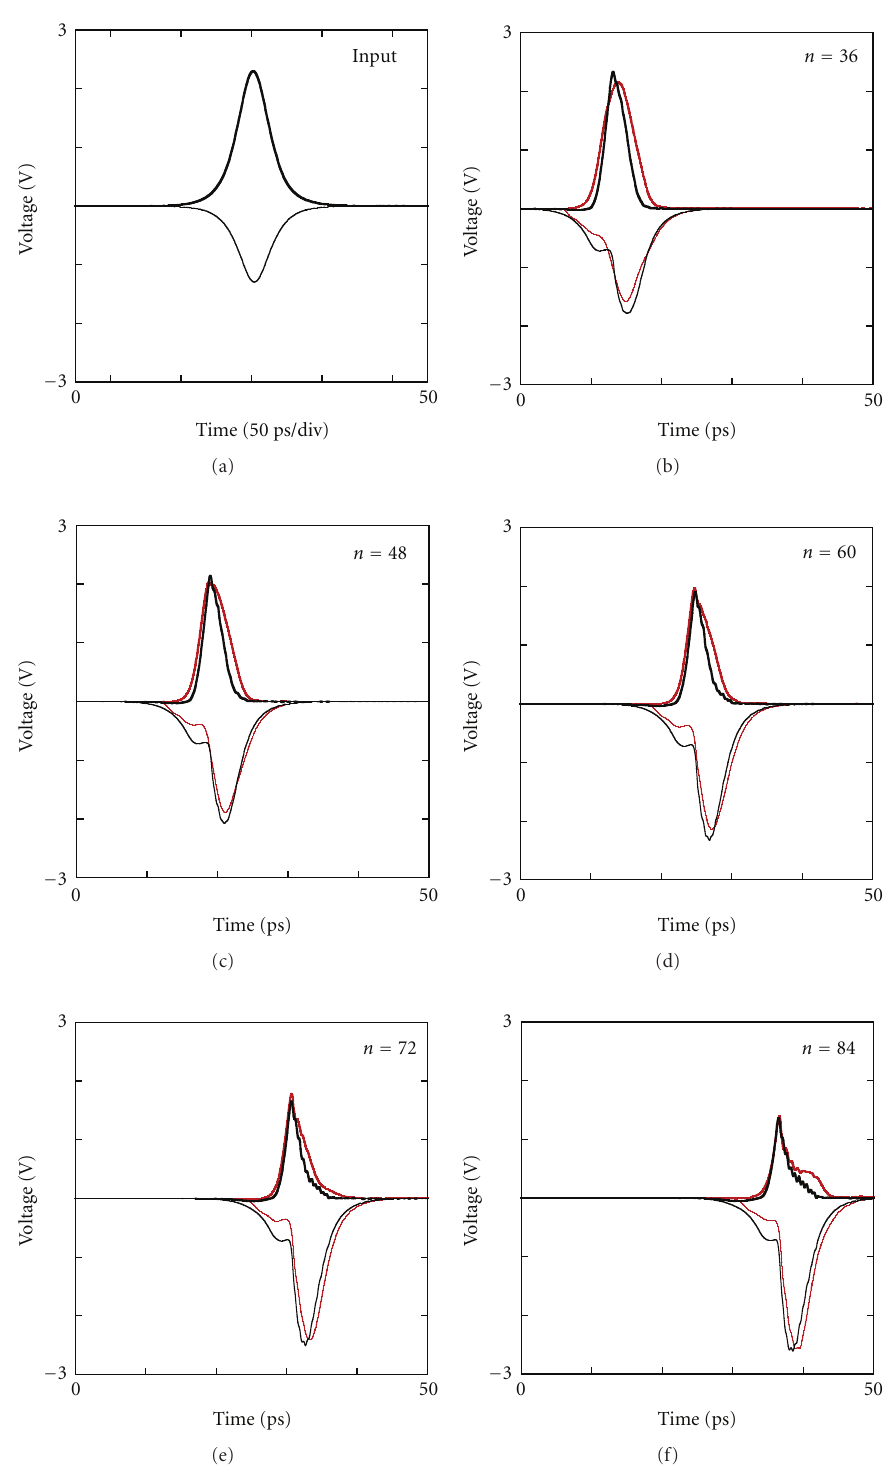
Figure 5: Wave propagation on test TWFET. The waveforms on the gate and drain lines are shown by the thin and thick curves, respectively. The black and red curves correspond to the quasi-TEM and FDTD calculations, respectively. (a) shows the input waveforms. Waveforms recorded at the n th FET cell are shown. (b), (c), (d), (e), and (f) represent the waveforms at n = 36, 48, 60, 72, and 84,